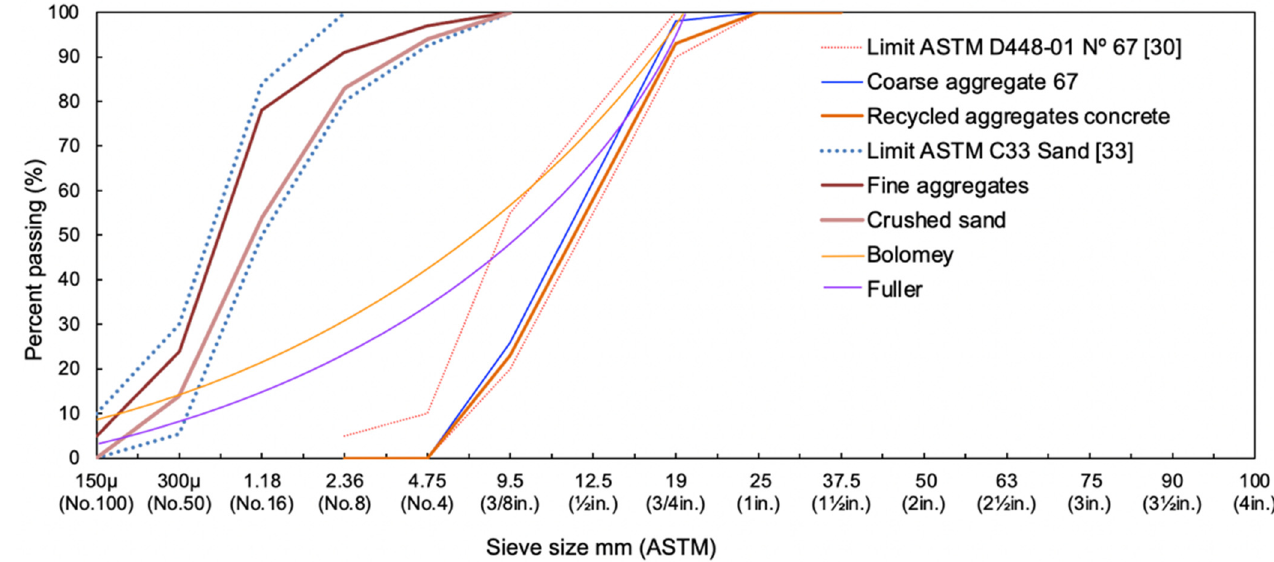
Figure 1. Grain size distribution curve of fine and coarse aggregate. Table 4. Coarse aggregate Absorption from San Eduardo Plant.